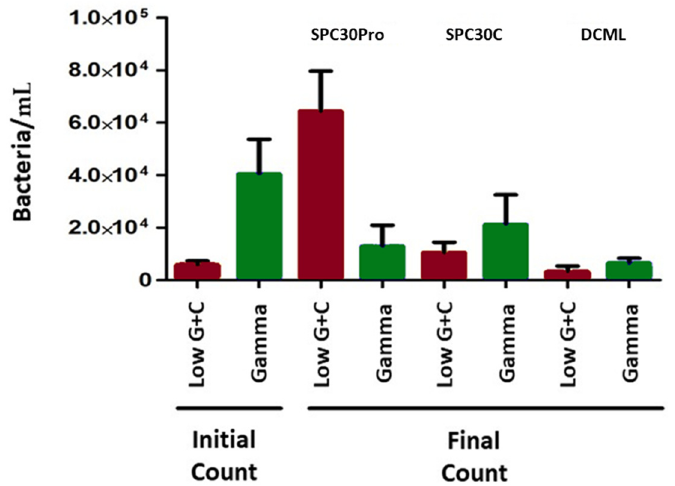
Figure 3. FISH of intestinal samples taken from totoaba fed with SPC30Pro diet at the beginning and end of the trial; ( a ) low G + C Gram-positive control strain ( Bacillus subtilis 9b); ( b ) Low G + C Gram-positive bacteria from intestine samples at the beginning of the study; ( c ) Low G + C Gram-